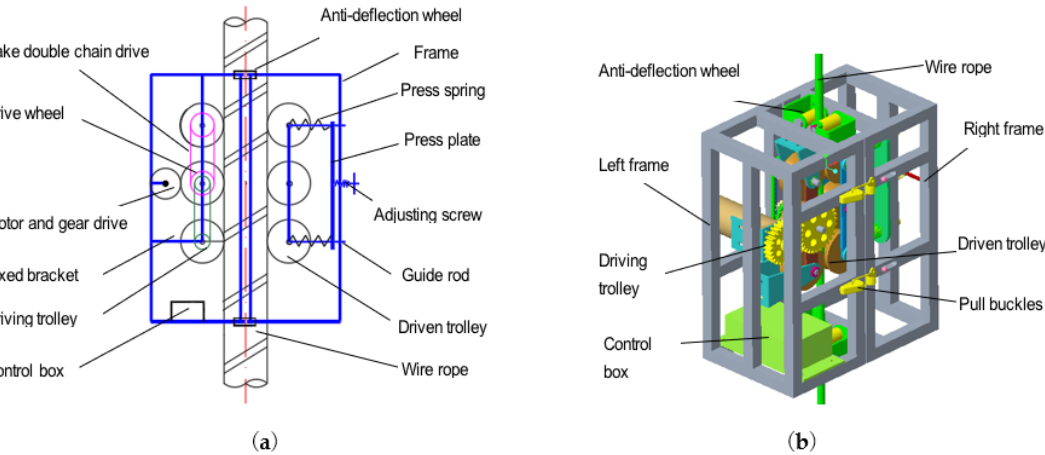
Figure 2. Wheeled climbing robot for wire rope for the sluice. ( a ) 2D schematic diagram of the robot, and ( b ) 3D CAD structure of the